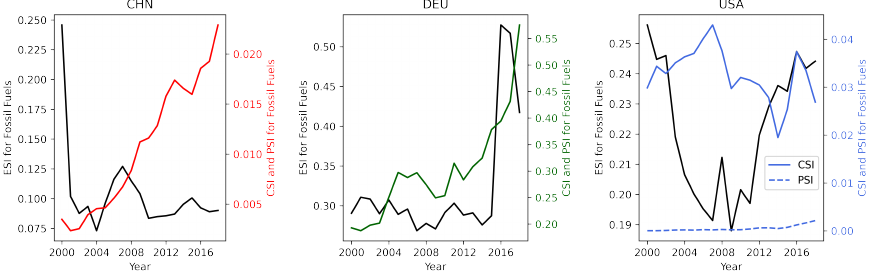
Figure 16. Comparison of ESI and CSI